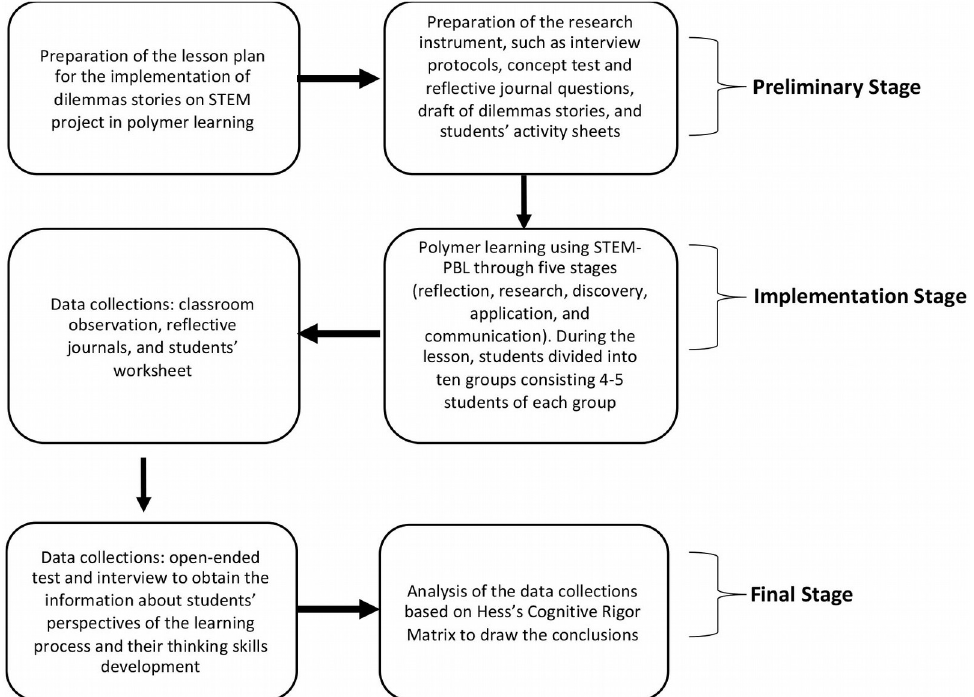
Figure 1. Research Flow and Data